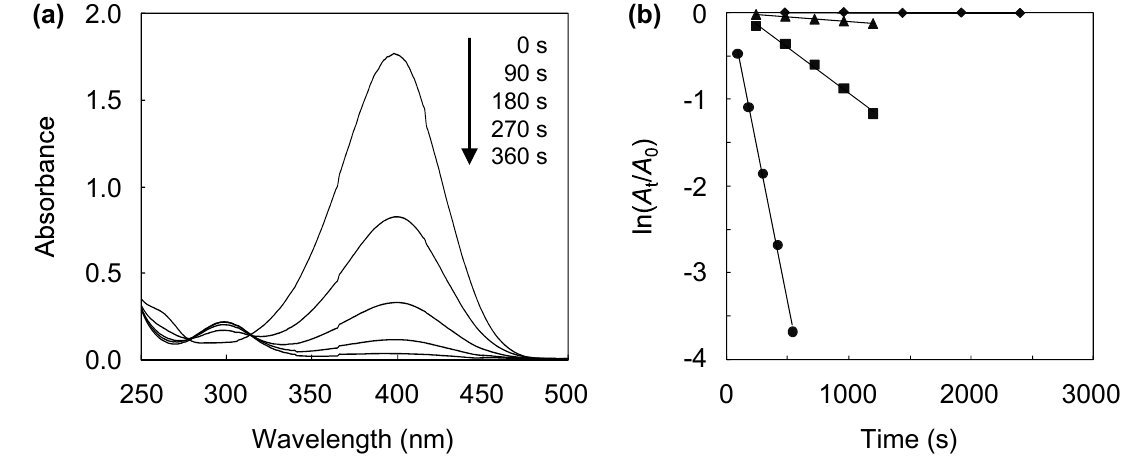
Figure 5. Catalytic performances of the AuAgNPs @ ZnO whiskers. ( a ) UV-vis absorption spectra throughout the catalytic reduction of 4-NP over AuAgNPs @ ZnO whiskers, ( b ) ln( A / A ) versus reaction time for the reduction of 4-NP; AuAgNPs @ ZnO whiskers t 0 (circles), AuNPs @ ZnO whiskers (squares), AgNPs @ ZnO whiskers (triangles) and the original ZnO whiskers (diamonds). A and A are the initial absorbance and absorbance at 0 t time t at 400 nm. AuAgNPs @ ZnO whisker: Au = 0.07 µmol and Ag = 0.03 µmol, AuNPs @ ZnO whisker: Au = 0.1 µmol, AgNPs @ ZnO whisker: Ag = 0.1 µmol. 4-NP: 15 µmol, NaBH : 3.0 4